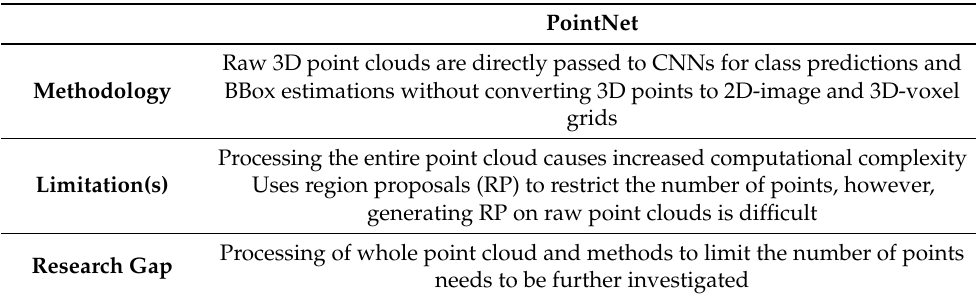
Table 15. Methodology and Limitation(s): PointNet-based 3DOR